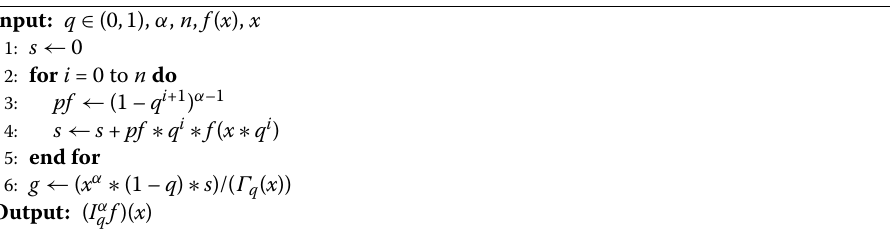
Algorithm 4 The proposed method for calculated ( I α